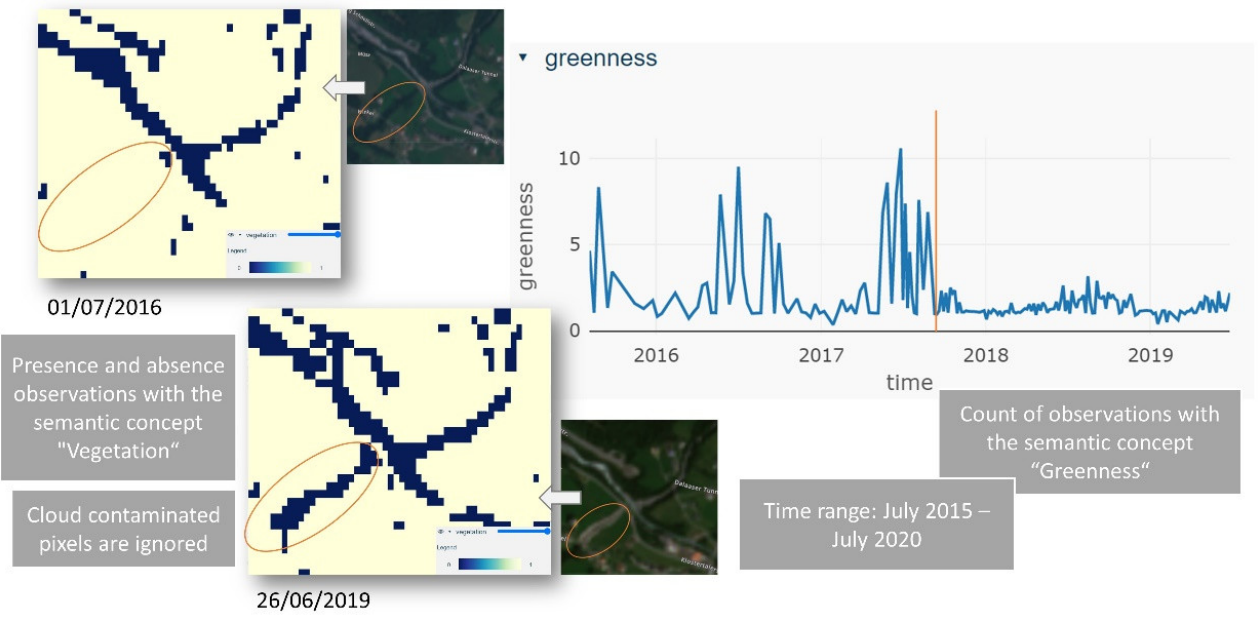
Figure 10. Semantic query using Sen2Cube.at for a debris flow event, showing presence / absence observations of the semantic concept vegetation in the area identified by a point-based event indication (left part). The time series analysis (right part) shows a follow up analysis of the identified affected area using a greenness index for long term monitoring of the event, based on all available Sentinel-2 datasets (cloud-filtered) between July 2015 and July 2020.